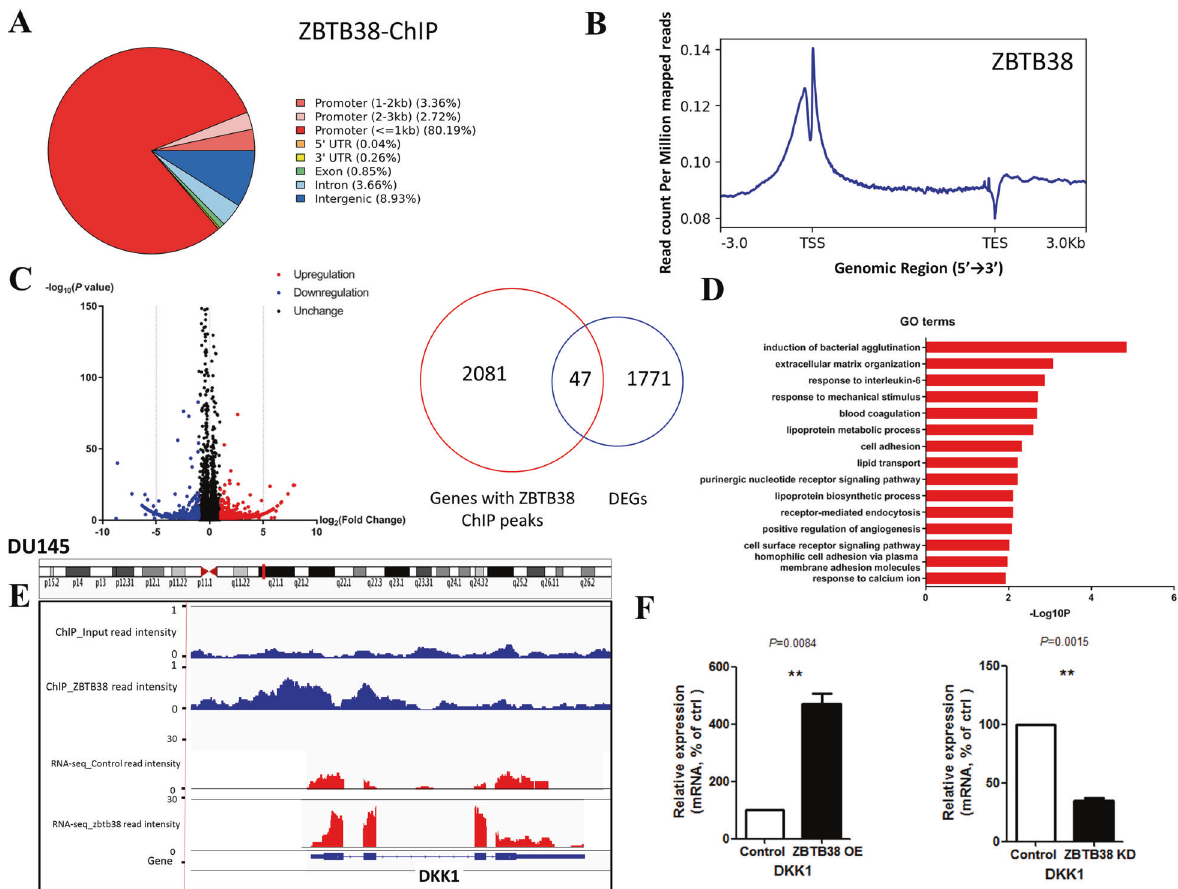
Fig. 3 ZBTB38 binds the promoters and regulates the expression of its target genes in DU145 cell. A Genome distribution of HA- ZBTB38 ChIP-seq peaks in DU145 cells. B Signal plot of HA- ZBTB38 ChIP-seq signals in DU145 cells. C Volcano plot for DEGs in ZBTB38 overexpression DU145 RNA-seq. Right panel: the overlap of ChIP-seq peaks and DEGs. D GO analysis (biological process, BP) of downregulated genes after ZBTB38 overexpression in DU145 cells using the DAVID program. E A representative snapshot of ZBTB38 ChIP-seq and RNA-seq signals located in DKK1 gene locus. F RT-qPCR analyses of the mRNA levels of DKK1 gene in the DU145 cells with a control vector or ZBTB38 overexpression or ZBTB38 knockdown. (**P < 0.01, ***P < Supplementary Fig. 2C, PRKDC knockdown did not in fl uence ZBTB38 expression, thus excluding this possibility. Taken together, these fi ndings uncovered the tumor-suppressive roles of ZBTB38